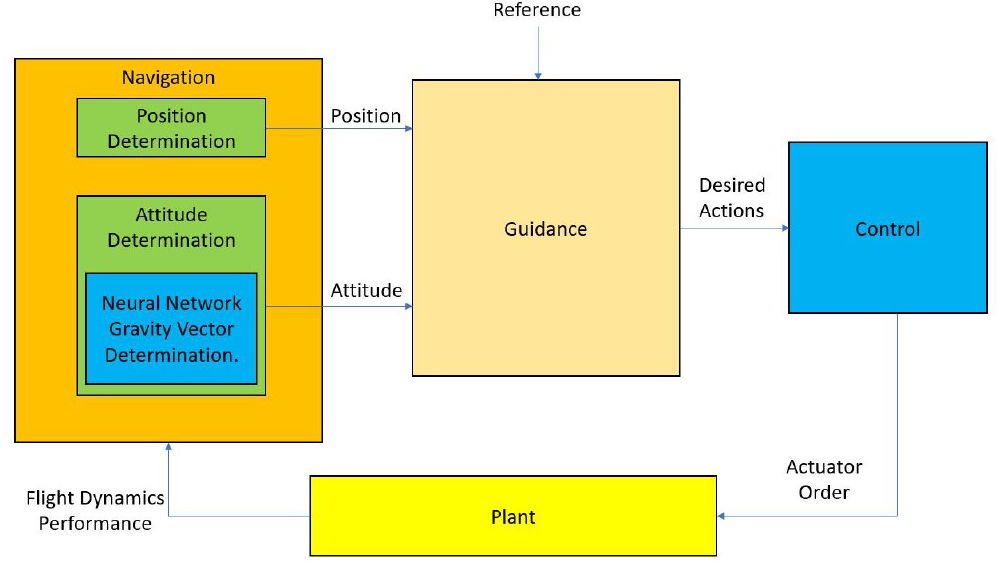
Figure 2. Scheme of the GNC